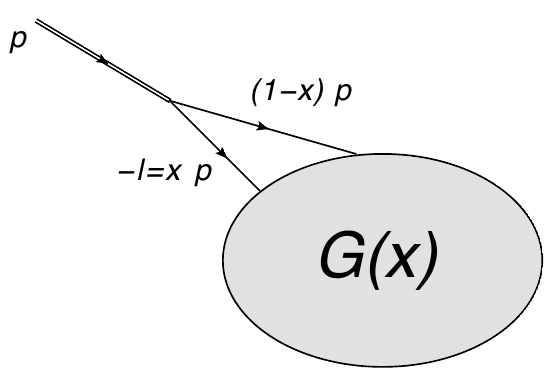
Figure 5 . A generic representation of a collinear